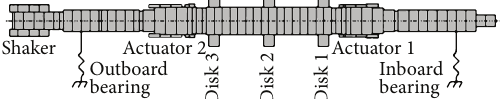
Figure 10. The LOP load orientations were conducted with a bearing preload of 0.1 at the operating speed of 10,000